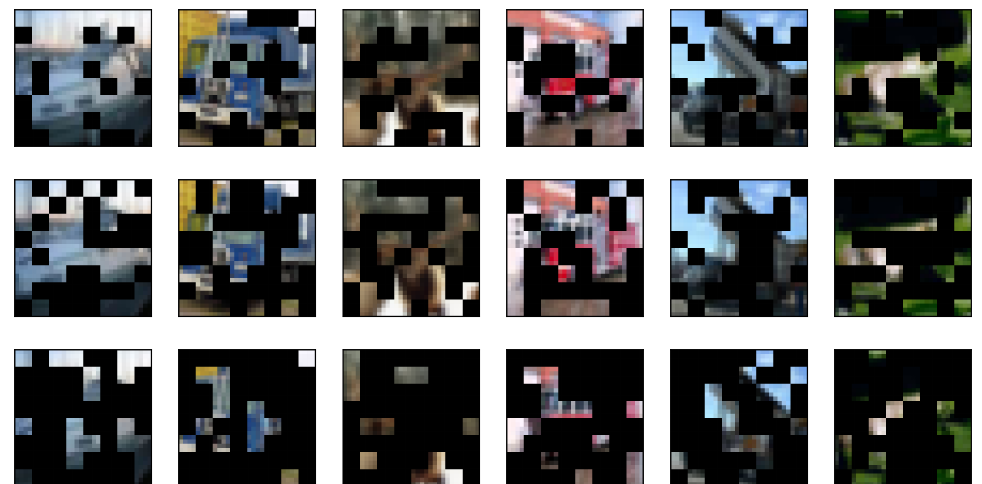
Figure 4. Images from CIFAR-10 with different masking rates applied. From top to bottom, 1/3, 1/2, and 3/4 rates are respectively applied on the same images.